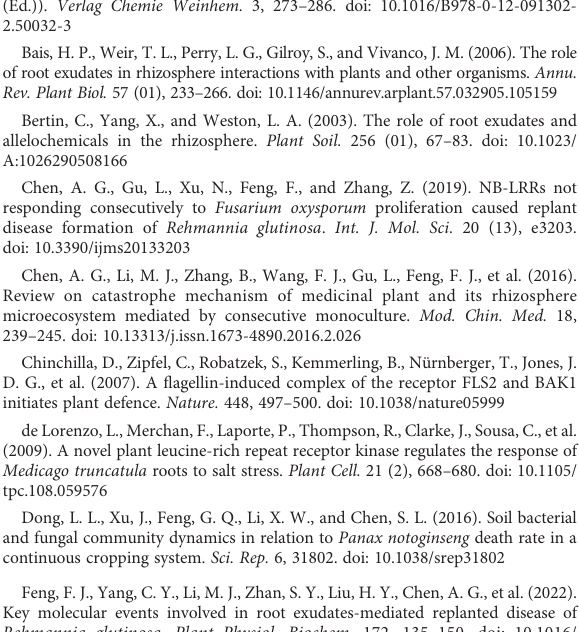
Antioxygen enzyme activities and MDA content analysis of root segments with transient overexpression and RNAi of nine RgLRRs under